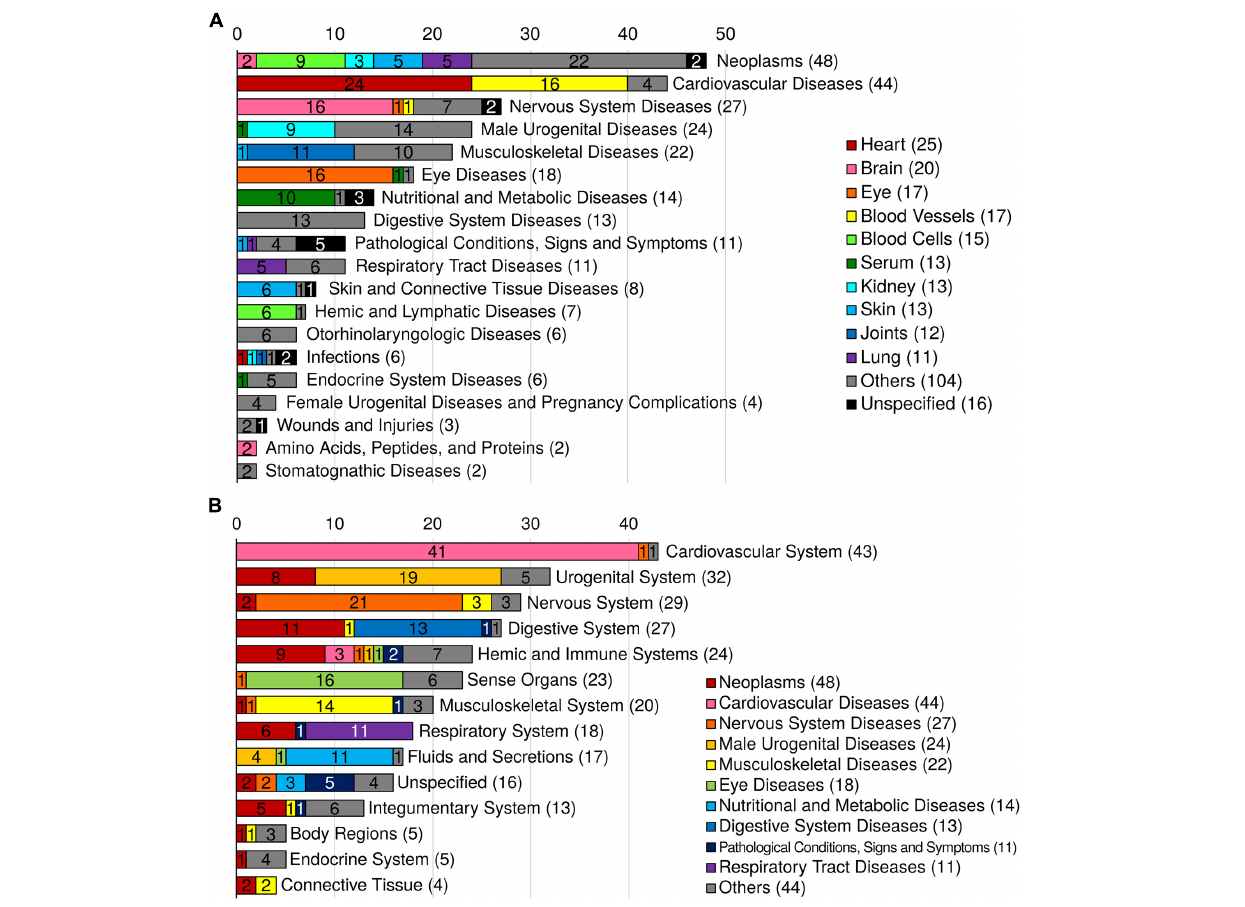
FIGURE 2 | Summary of 276 MeSH disease and anatomy terms. (A) Distribution of the ARD MeSH disease categories and their corresponding tissues. The colors indicate the corresponding tissue. (B) Distribution of the ARD MeSH anatomy categories and their corresponding MeSH disease categories of ARDs. The colors indicate the corresponding MeSH disease